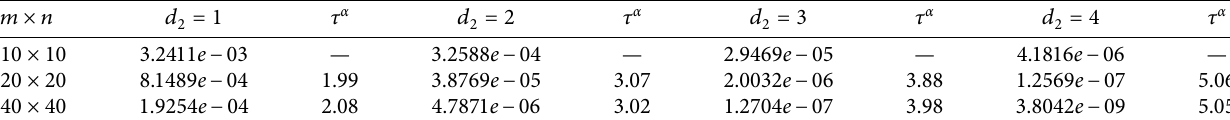
� 9 for Example 3. 1